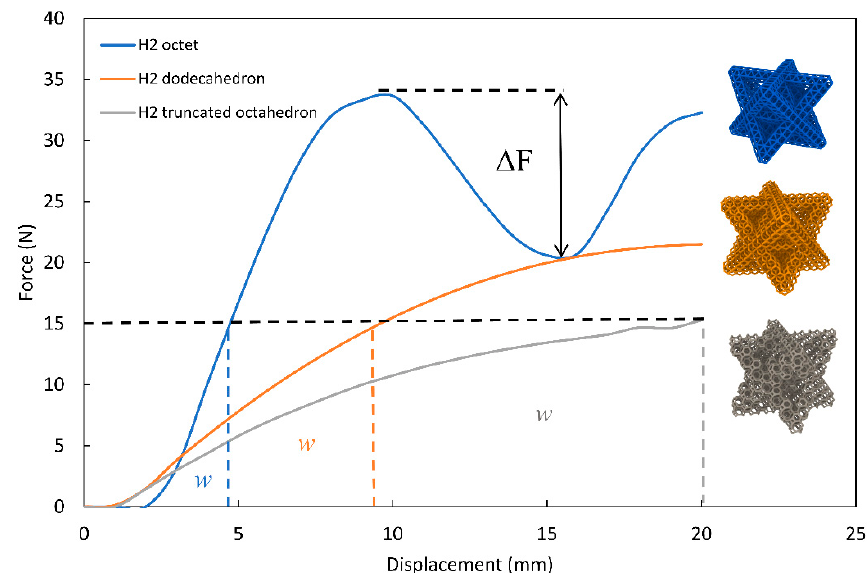
Figure 5. Compression behavior for various 2nd order lattices.